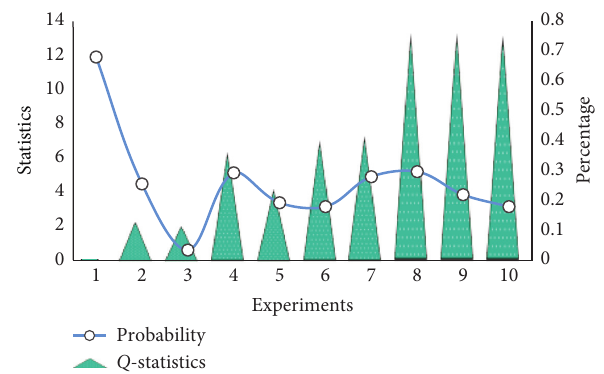
Figure 8: Q -test of GDP series.